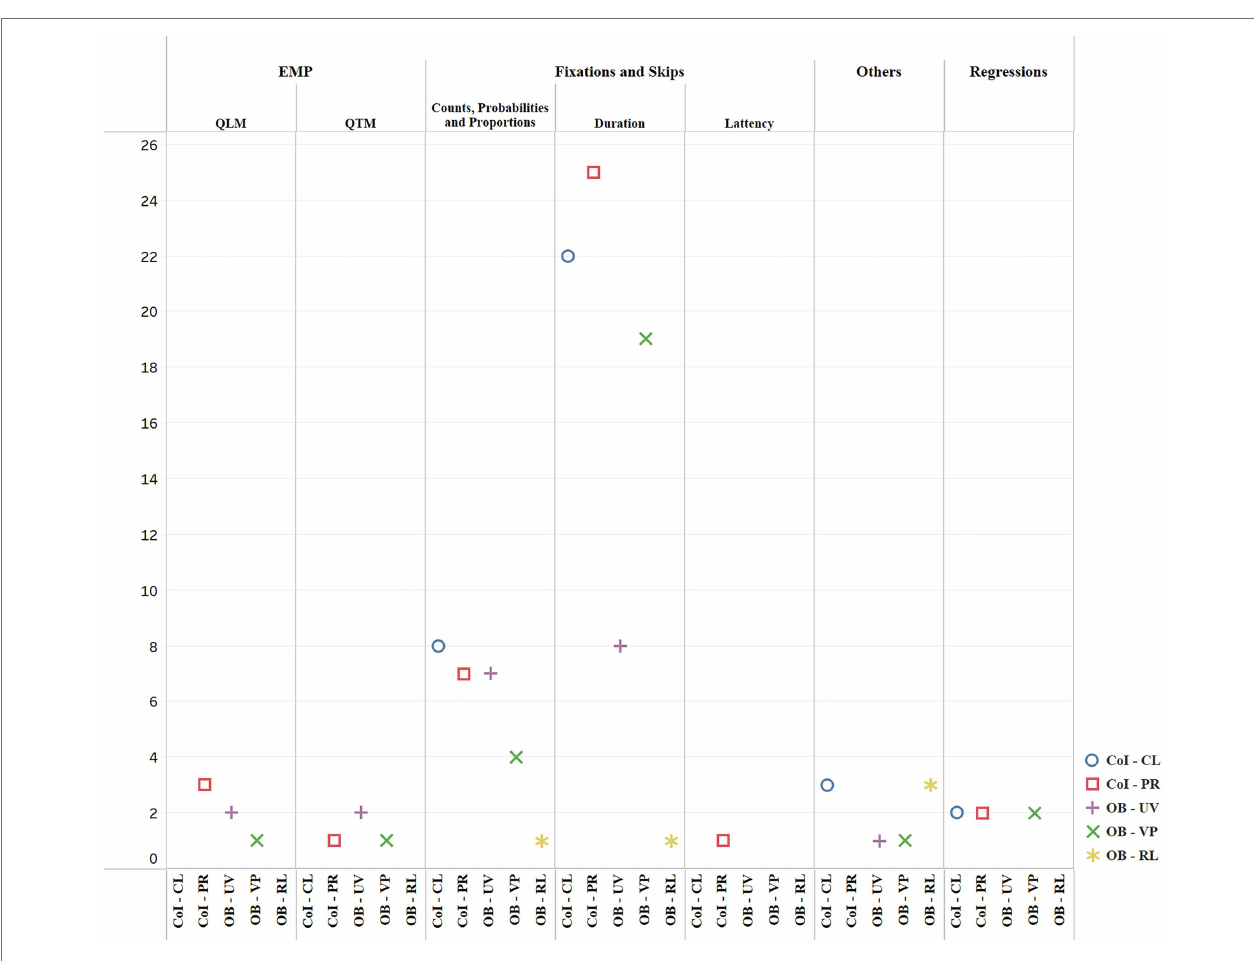
FIGURE 7 | Themes and choice of measures and their